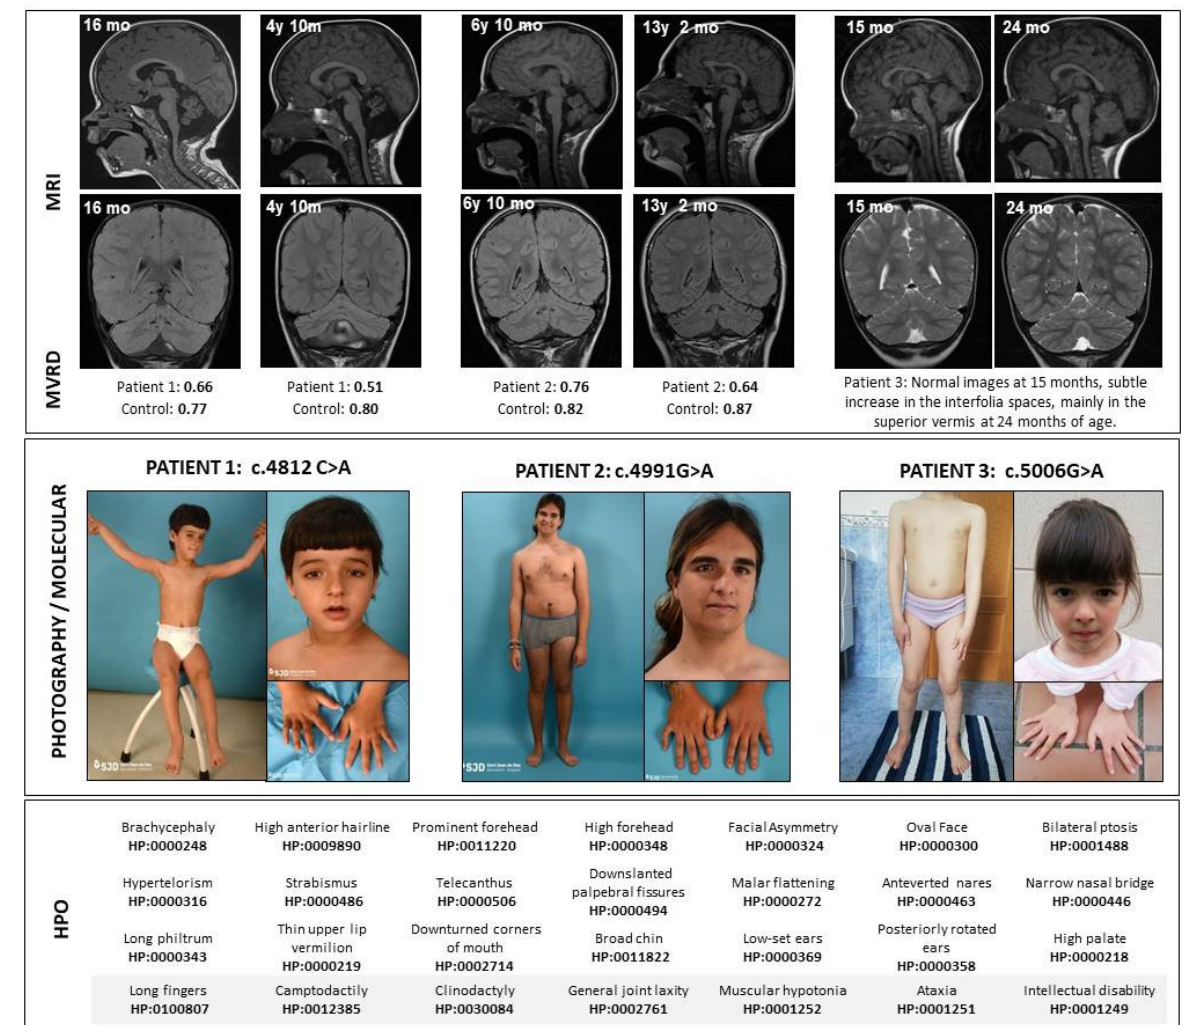
Figure 1. Clinical and radiological features of patients. Above, the magnetic resonance sagittal and coronal images show a progression in the cerebellar atrophy in Patients 1 and 2, despite clinical stabilization. Immediately below the images, the midsagittal vermis relative diameter (MVRD) has been calculated in the sagittal sequences for patients 1 and 2. MVRDs are detailed and compared to controls’ values. In the middle, pictures from the patients are shown. In the bottom, Human Phenotype Ontology (HPO) codes are included. y: years; mo: months; MVRD: midsagittal vermis relative diameter.